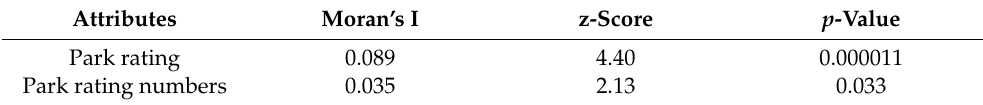
Table 3. Global spatial autocorrelation results.